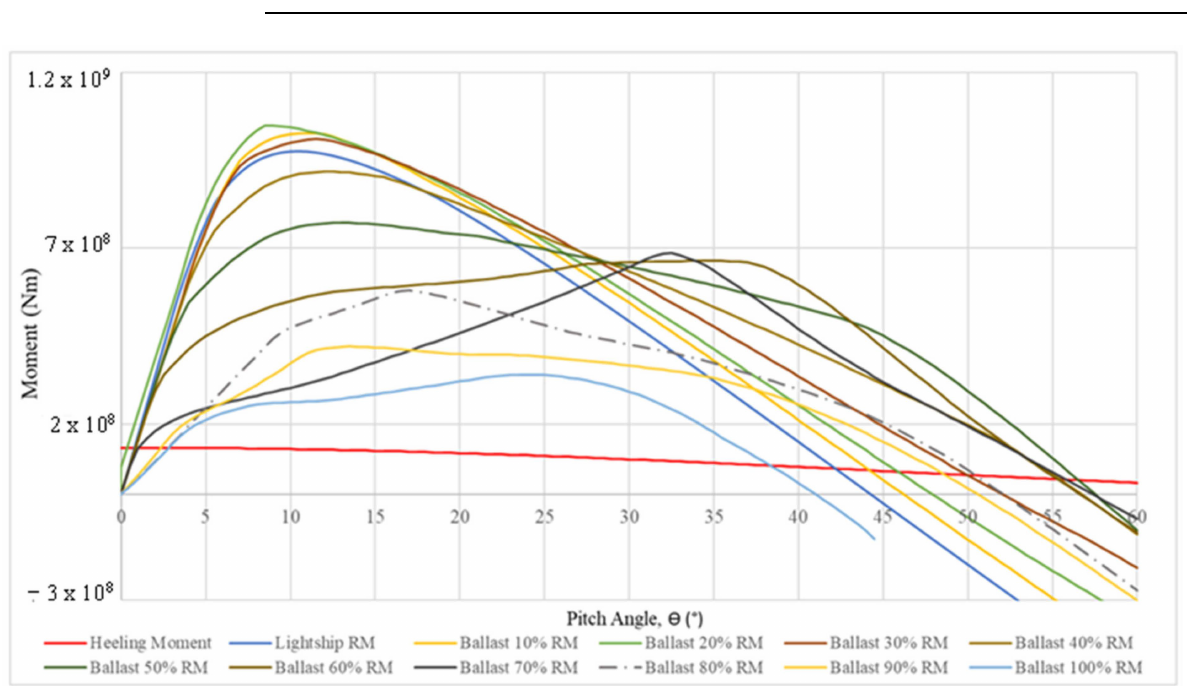
Figure 10. Moment curves about the pitching